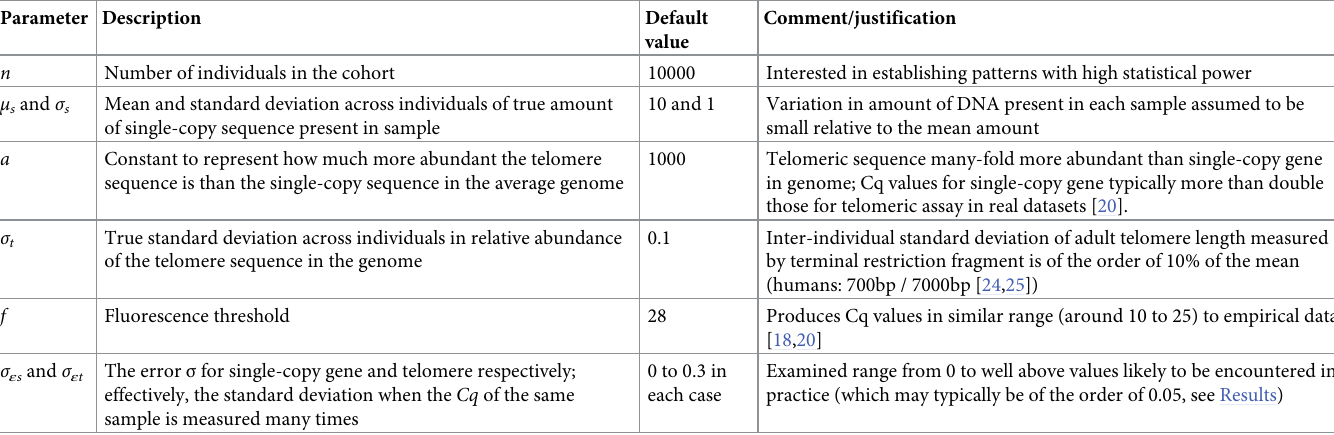
Table 1. Default values chosen for simulation